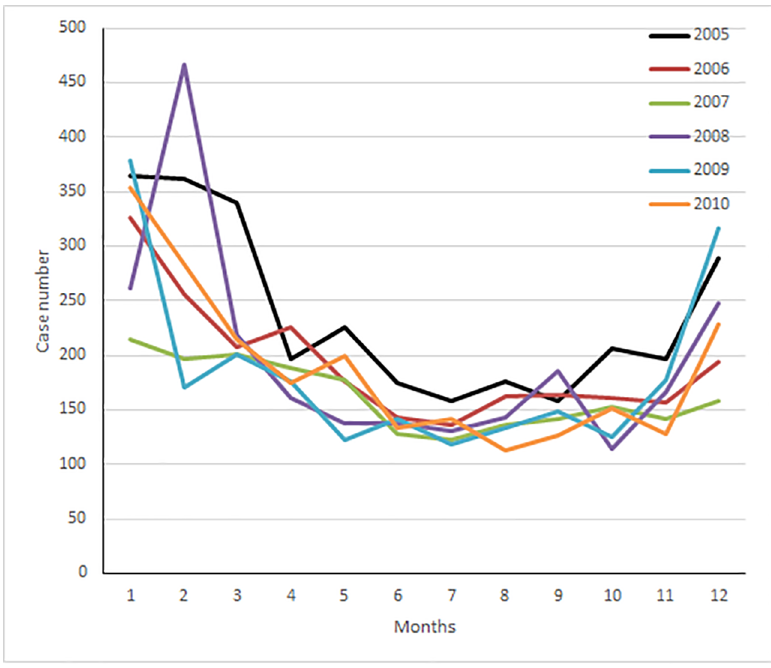
Fig 3. Number of patients with carbon monoxide poisoning during the study